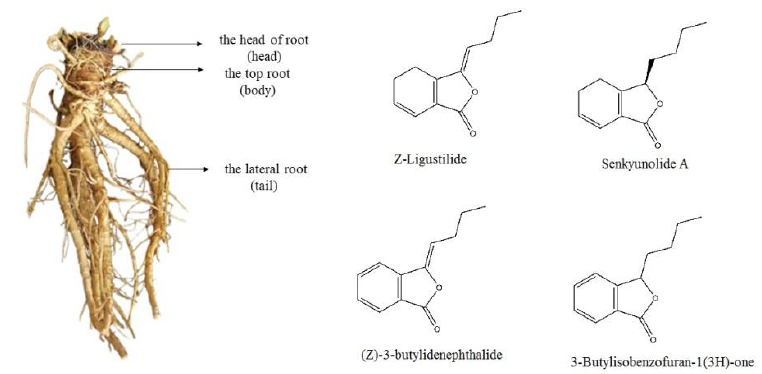
Figure 1. The photo of A. sinensis root and structures of main components.